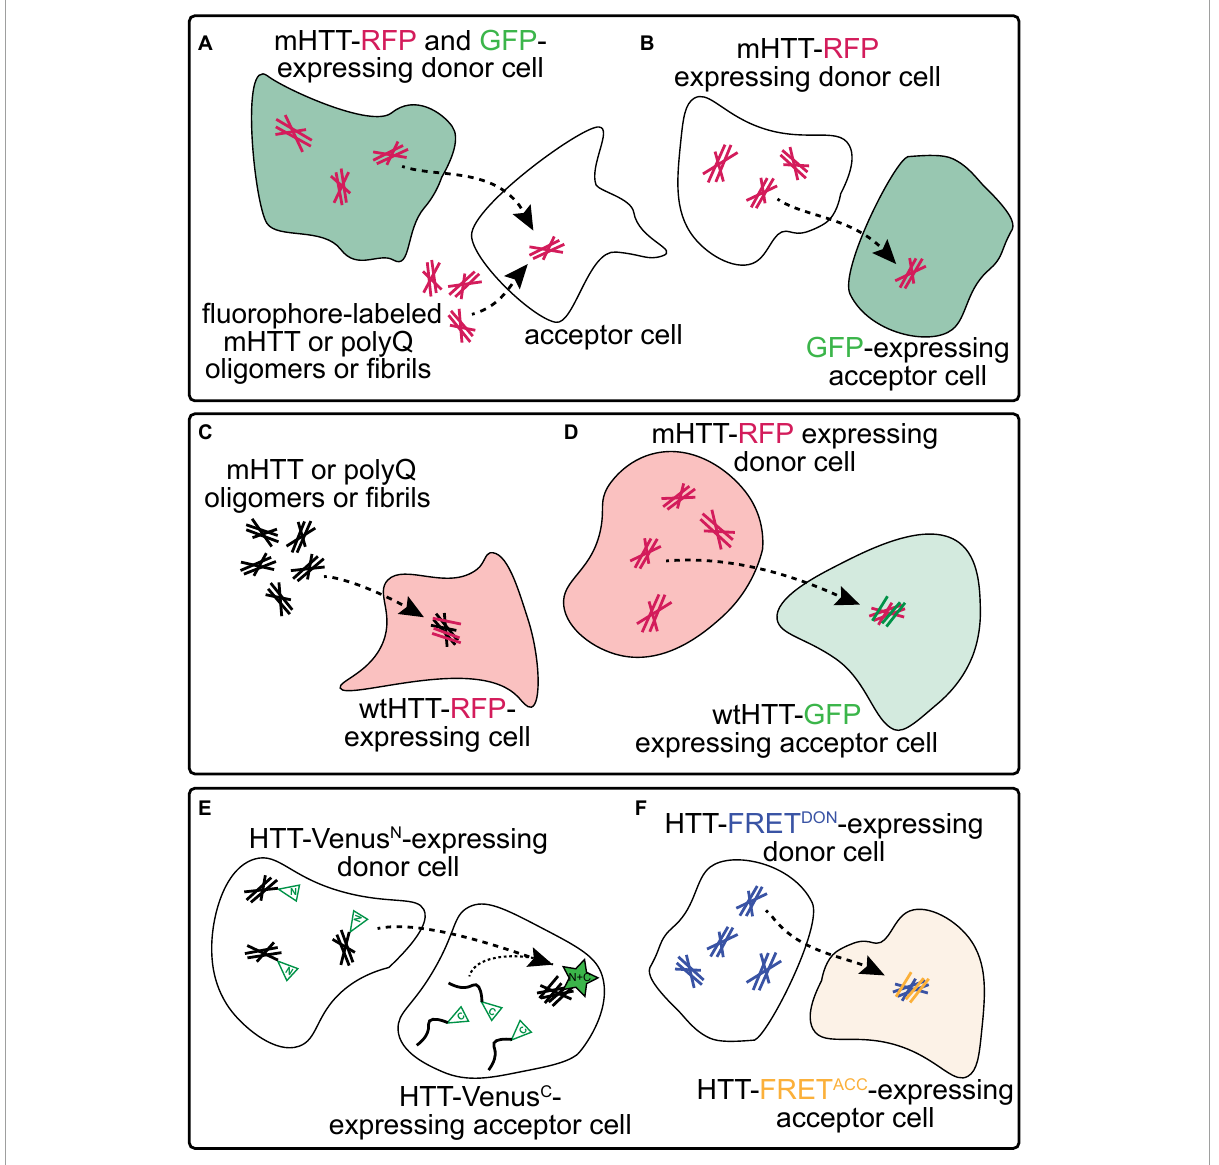
FIGURE2 Experimental approaches to monitor prion-like behavior of mHTT proteins. (A) Spreading of mHTT can be reported as a time-dependent loss of co-localization between mHTT-FP expressed in “donor” neurons and a co-expressed non-transmissible cytoplasmic protein marker such as synaptophysin- or synaptotagmin-GFP. This approach has been used to monitor the transmissibility of mHTT proteins in mouse and fly brains (see Table 1 ). A similar approach in vitro monitors internalization of exogenous fluorescently-labeled mHTT or polyQ aggregates by several unlabeled “acceptor” cell types, including neuronal cell lines (e.g., SH-SY5Y, Neuro2A, and PC12), COS-7 fibroblast-like cells, and THP1 macrophages. (B) Transfer of mHTT-FP proteins from donor cells can also be detected by monitoring acquisition of mHTT-GFP signal within the cytoplasm of acceptor cells labeled by a soluble FP such as GFP, BFP, or mCherry. This approach has been used to demonstrate cell-to-cell mHTT spreading between neurons in mouse brain slices and cultured neuronal or primary neuron cells. (C) Entry of extracellular polyQ or mHTT fibrils into the cytoplasm of numerous cell types (e.g., HEK, HeLa, and PC12) causes templated aggregation of wtHTT-FP proteins, detected by a phenotypic change in wtHTT-FP expression pattern (e.g., diffuse → punctate) or decreased solubility measured by biochemical methods. (D) The seeding capacity of mHTT-FP aggregates can be measured by examining the aggregation of cytoplasmic wtHTT-FP proteins in acceptor cells templated by mHTT-FP aggregate seeds from donor cells. This approach has been applied to in vitro (e.g., in co-cultured